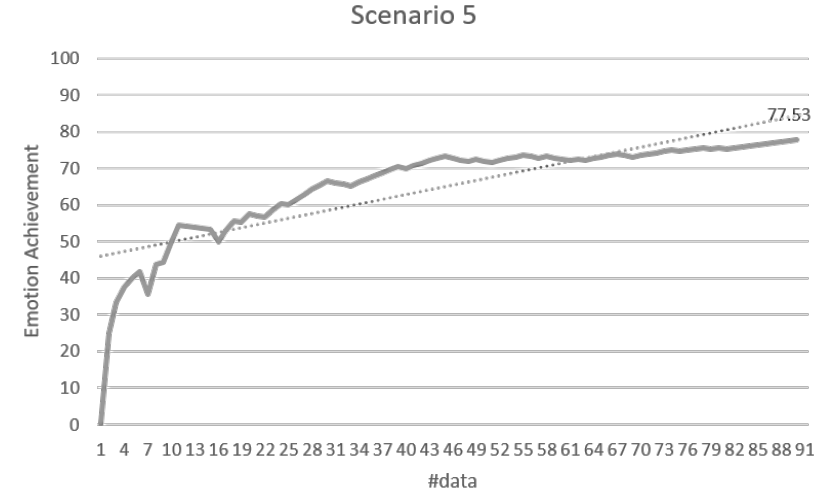
Figure 19. Emotion achievement for scenario 5. The thick line shows the increase of the achievement according to the number of sensory changes, and the dotted line shows the trend of this increase.